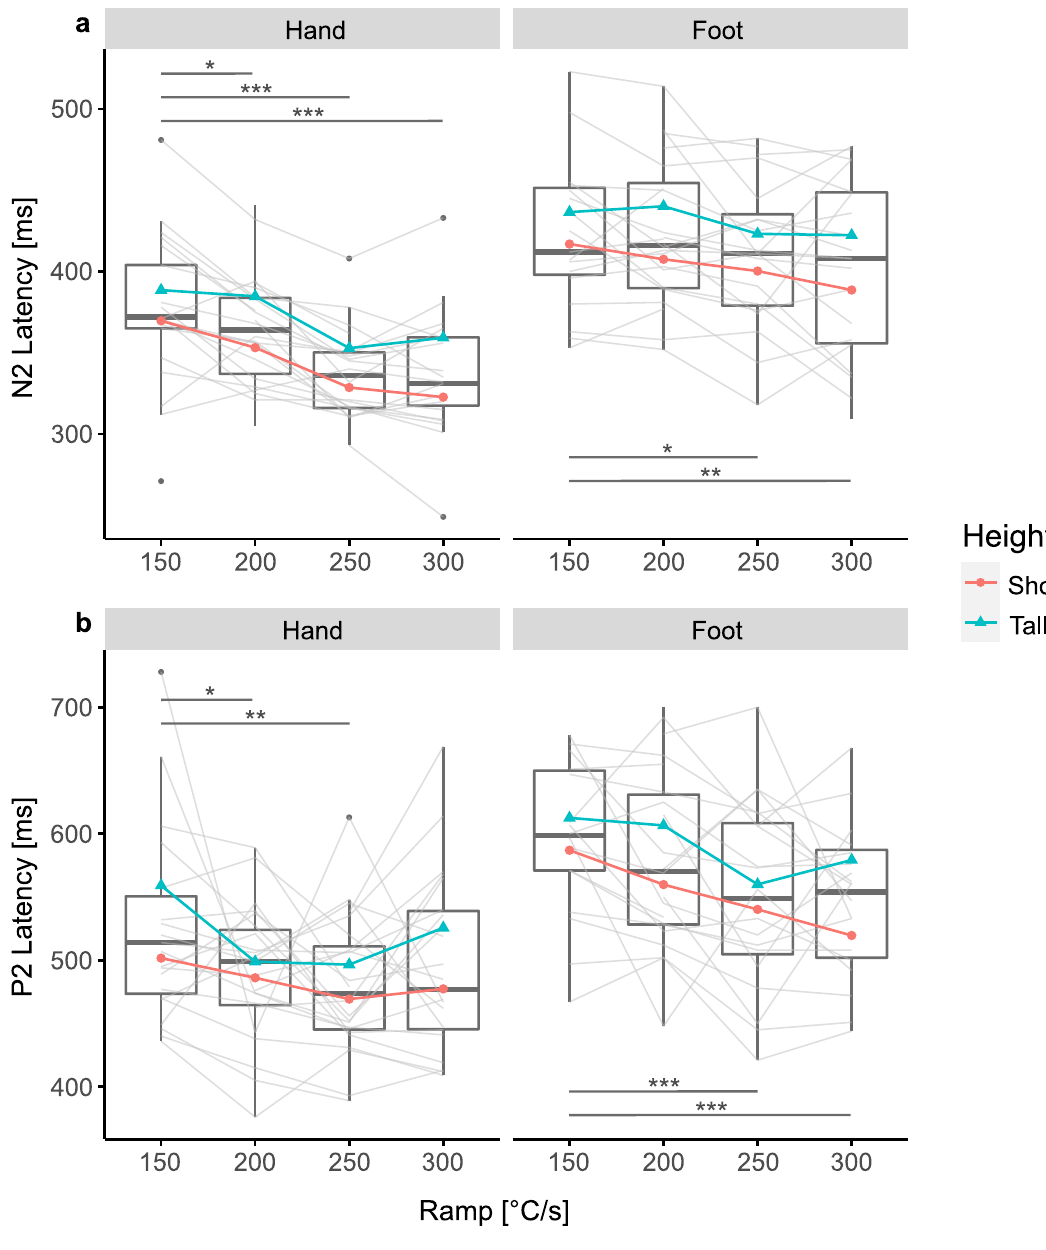
Figure 4. Contact heat evoked potential (CHEP) latency after contact heat stimulations with four different heating ramps. Hand and foot stimulations are illustrated on the left and right side, respectively. For an illustrative purpose, the mean of short (red) and tall (blue) subjects are shown; short < median height < tall. Significant differences due to the heating ramp are illustrated in grey. ( a ) CHEP N2 latency. ( b ) CHEP